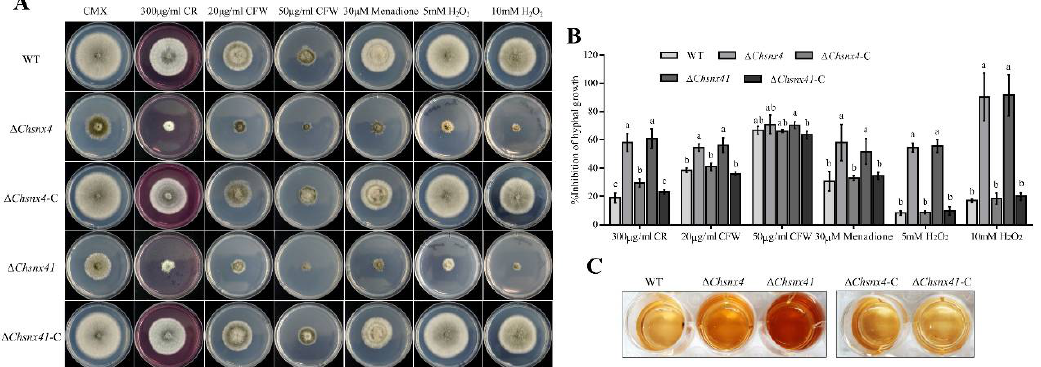
Figure 5. Sensitivity of WT, Δ Chsnx4 , Δ Chsnx4-C , Δ Chsnx41 , and Δ Chsnx41 -C to a variety of stress agents. ( A ) Colony morphology of indicated strains grown on CMX supplemented with Congo red (CR), calcofluor white (CFW), Menadione, and H 2 O 2 . ( B ) Statistical analysis of inhibition of hyphal growth of each strain under CR, CFW, Menadione, and H 2 O 2 stress conditions. ( C ) The mycelia of the indicated strains were stained with DAB. Each experiment had three replicates and was repeated three times.